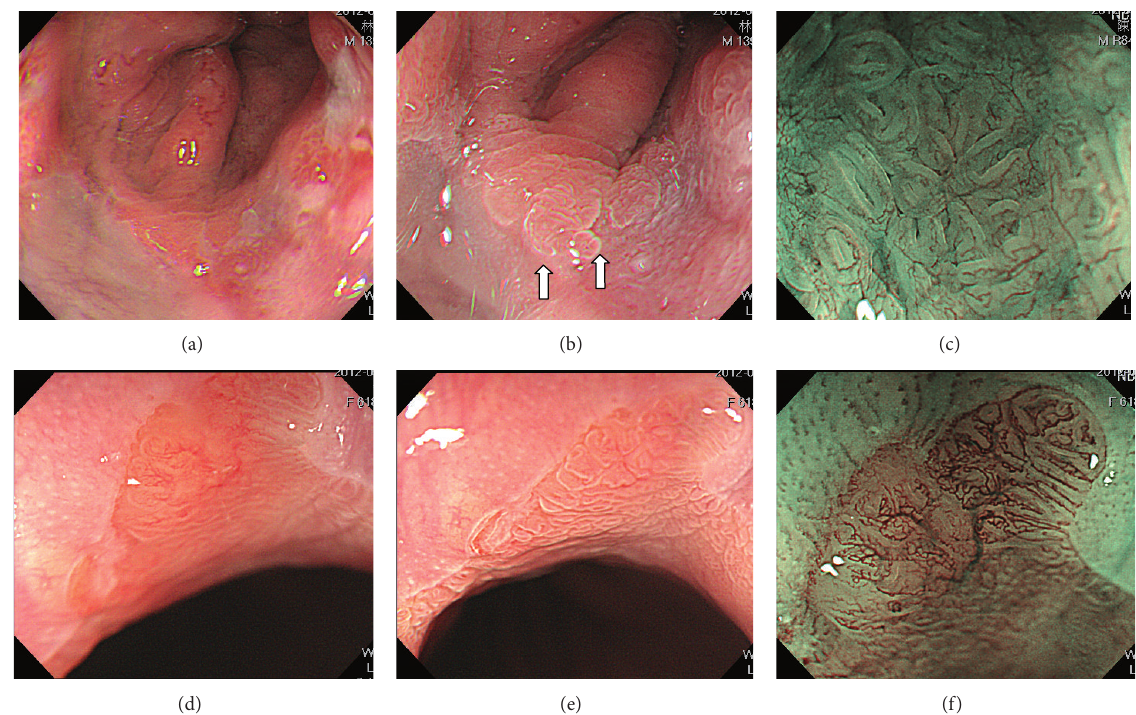
Figure 4: (a) White-light imaging endoscopy shows Barrett’s esophagus. (b) Chromoendoscopy with 2% acetic acid shows “acetowhitening” reaction of the mucosa with intestinal metaplasia. (c) Magnifying endoscopy with narrow-band imaging system reveals nondysplastic mucosa presenting cerebriform or gyri-like pit pattern with superficial blood vessels regularly situated between the mucosal ridges. (d) Magnifying endoscopy with white-light imaging shows increased vascularity of mucosa breaks which appears as a villous pit pattern (e) after acetic acid spraying. (f) Magnifying endoscopy under narrow-band imaging system disclosed low-grade dysplasia with irregular/disrupted mucosal patterns and irregular vascular patterns.